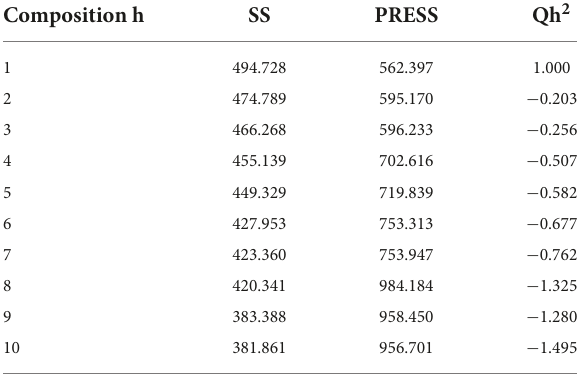
TABLE 4 Results of cross-validation